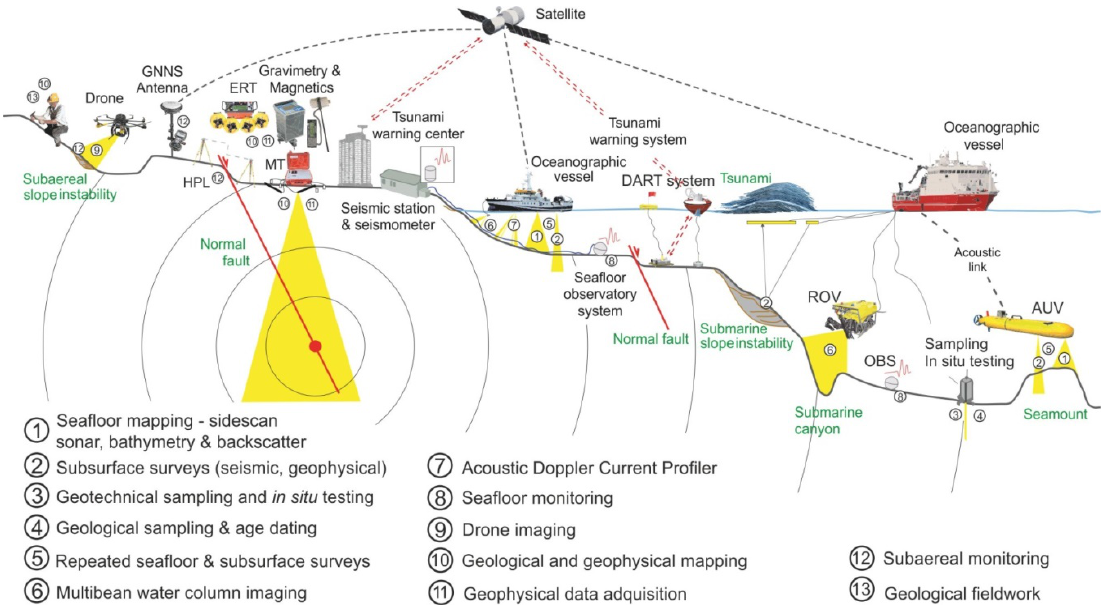
Figure 12. A distinctive methodological approach to study offshore geological hazards. The main future directions for studying offshore geohazards will be the implementation of multiscale and multidisciplinary approaches joining conventional and emerging tools for monitoring, mapping, direct observations, in situ testing, and modelling. Scenarios can be affected by multiple hazardous features, some in a land-marine transition context, and the integration of offshore and onshore observations is essential. The figure was used as idea and base to create a new one including more information from